Question: Summarize what this figure shows in one sentence.
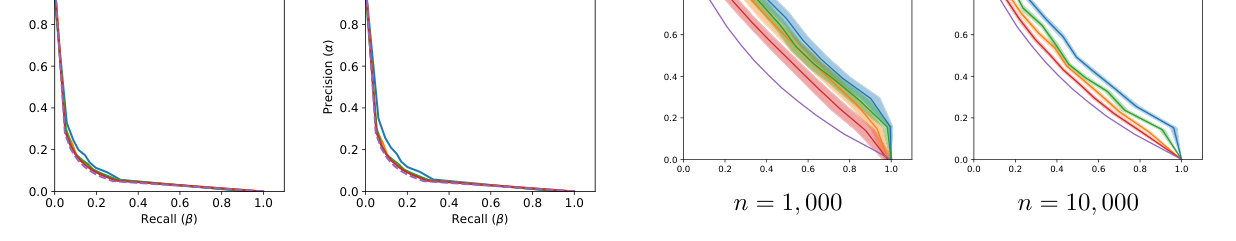
Answer: Influence of sample size n. The setting is the same as Fig. 2 for a translation of µ = .21 between two Gaussian in dimension d = 64 (with splitting and k = √n). Solid (respectively transparent) curves correspond to the empirical average (resp. deviations) of 100 PR curves computed from random samples. (see the text for more details).